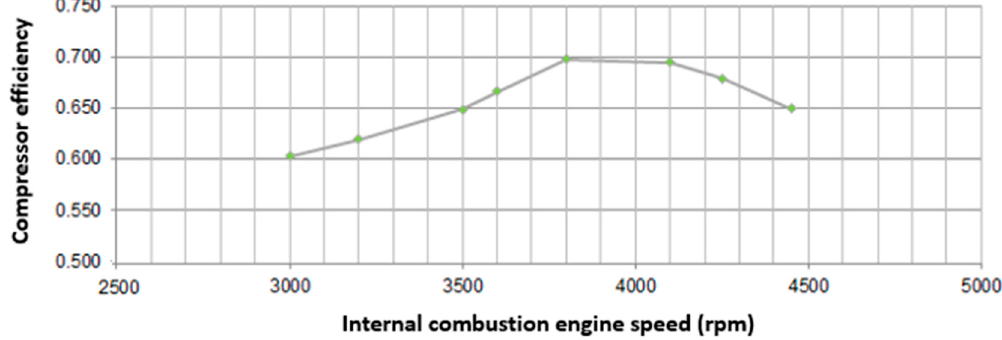
Figure 6. Compressor efficiency when it driven by a combustion engine.